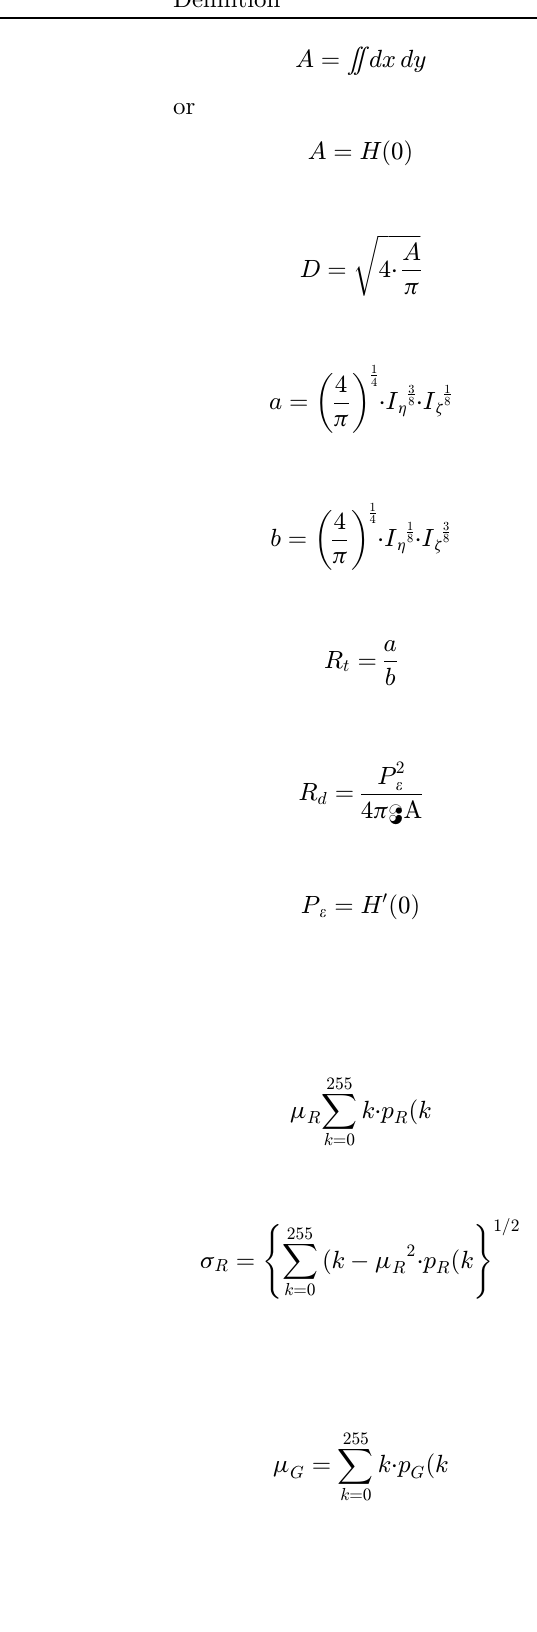
Table 6. Morphological